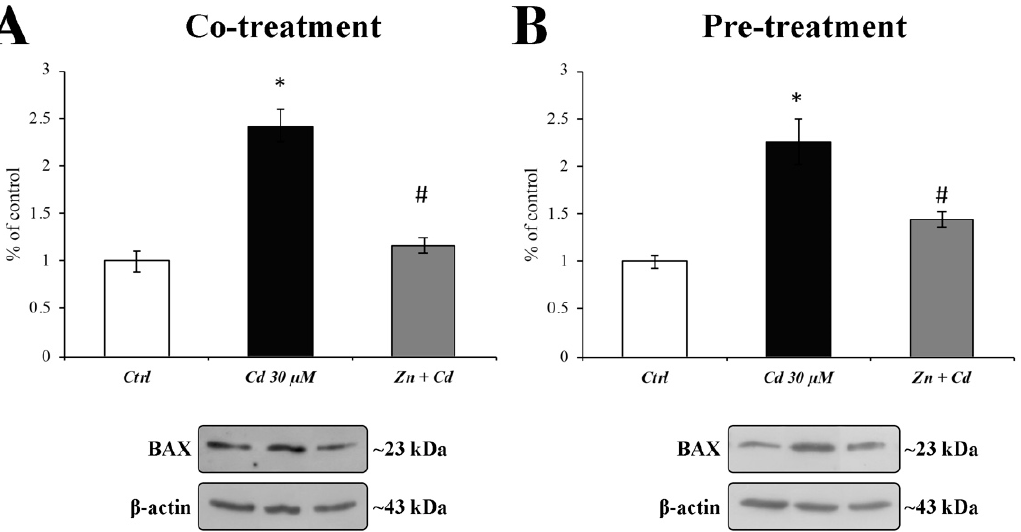
Figure 5. GRP78 protein expression after CdCl 2 and ZnCl 2 exposure. Histograms represent the quantitative analysis of the GRP78 protein expression levels evaluated by Western blotting. A significant increase in GRP78 levels (indicative of ER stress) during CdCl 2 30 µ M treatment (black columns) was revealed. This protein increment was prevented by ZnCl 2 50 µ M (grey columns), both in cotreatment ( A ) and 24 h pretreatment ( B ) regimens. Results are expressed as mean ± SEM and control (untreated cells) was arbitrarily taken as 100%. The β -actin housekeeping protein was used as an internal control for protein normalisation. Each experiment point was performed in triplicate, from three different sets of experiments. * p < 0.05 vs. Ctrl; # p < 0.05 vs. Cd treatment.